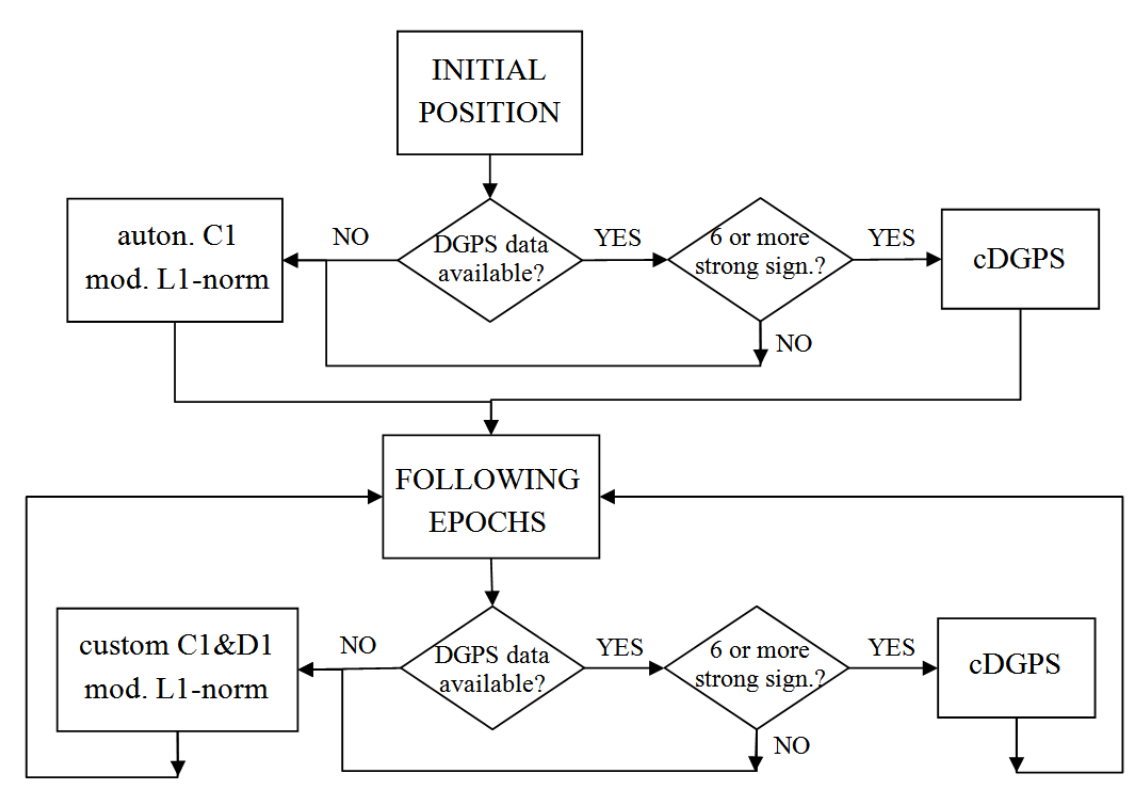
Figure 1. Flowchart of the custom positioning